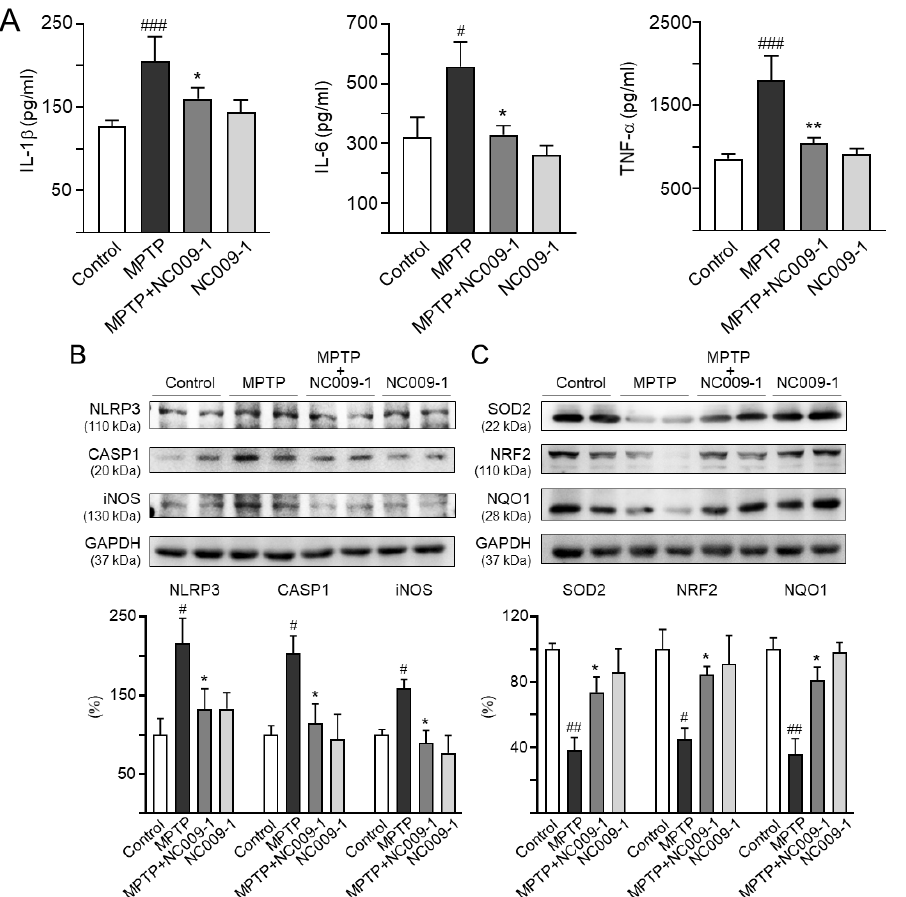
Figure 5. NC009 ‐ 1 down ‐ regulated neuroinflammation and up ‐ regulated cellular redox signaling in MPTP ‐ treated mice. ( A ) Expression levels of striatal IL ‐ 1 β , IL ‐ 6, and TNF ‐α analyzed by ELISA ( n = 6). Expression levels of ( B ) NLRP3, CASP1, iNOS, and ( C ) SOD2, NRF2, and NQO1 in striatum analyzed by Western blot ( n = 6). GAPDH was included as a loading control. To normalize, the relative NLRP3, CASP1, iNOS, SOD2, NRF2, and NQO1 of control mice was set as 100%. p values: comparisons between MPTP and control ( # p < 0.05, ## p < 0.01, ### p < 0.001), or NC009 ‐ 1 ‐ treated and untreated MPTP mice (* p < 0.05, ** p < 0.01).